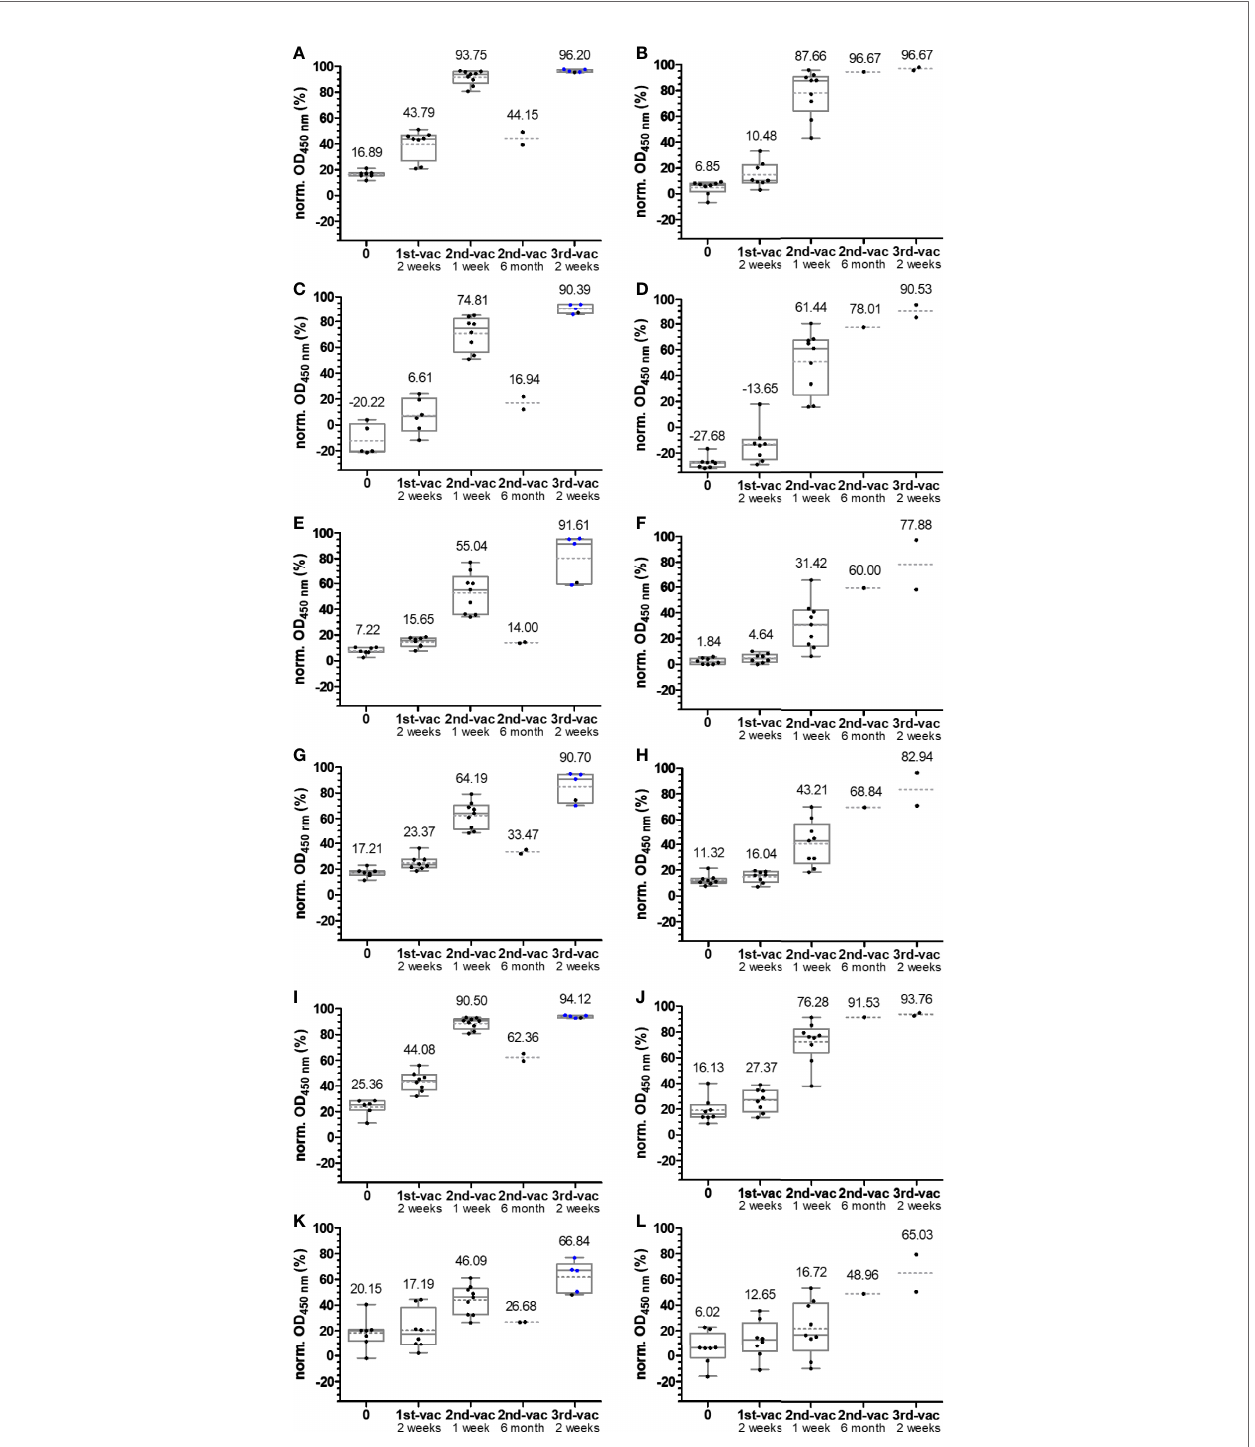
FIGURE 5 | Box plots of the normalized OD 450 values obtained in the inhibition assay using wild-type (A, B) , alpha (C, D) , beta (E, F) , gamma (G, H) , delta (I, J) , and omicron RBDs (K, L) . Serum or plasma samples were obtained from people vaccinated with mRNA-1273 (left panels A, C, E, G, I, K ) or BNT162b2 (right panels B, D, F, H, J, L ). Sera collected from people with heterologous booster vaccinations (2× mRNA-1273 and once BNT162b2) are indicated as blue dots. The median values are provided above the boxes and are additionally indicated as gray horizontal lines in the boxes, while the mean values are shown as gray horizontal dotted